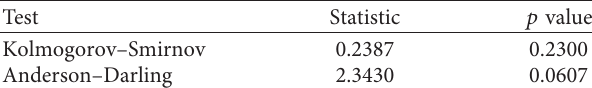
Table 6: Goodness-of-fit test results.